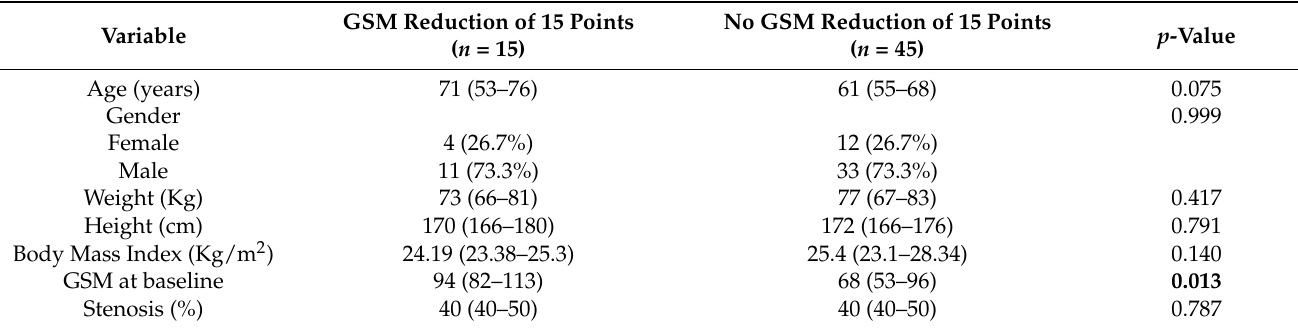
Table 4. Patients’ characteristics according to a GSM reduction of 15 points from baseline. Intent-to-treat (ITT) analysis (the significant p -value is unrelated to the treatment arm). Statistically significant p -value (<0.05) are highlighted.